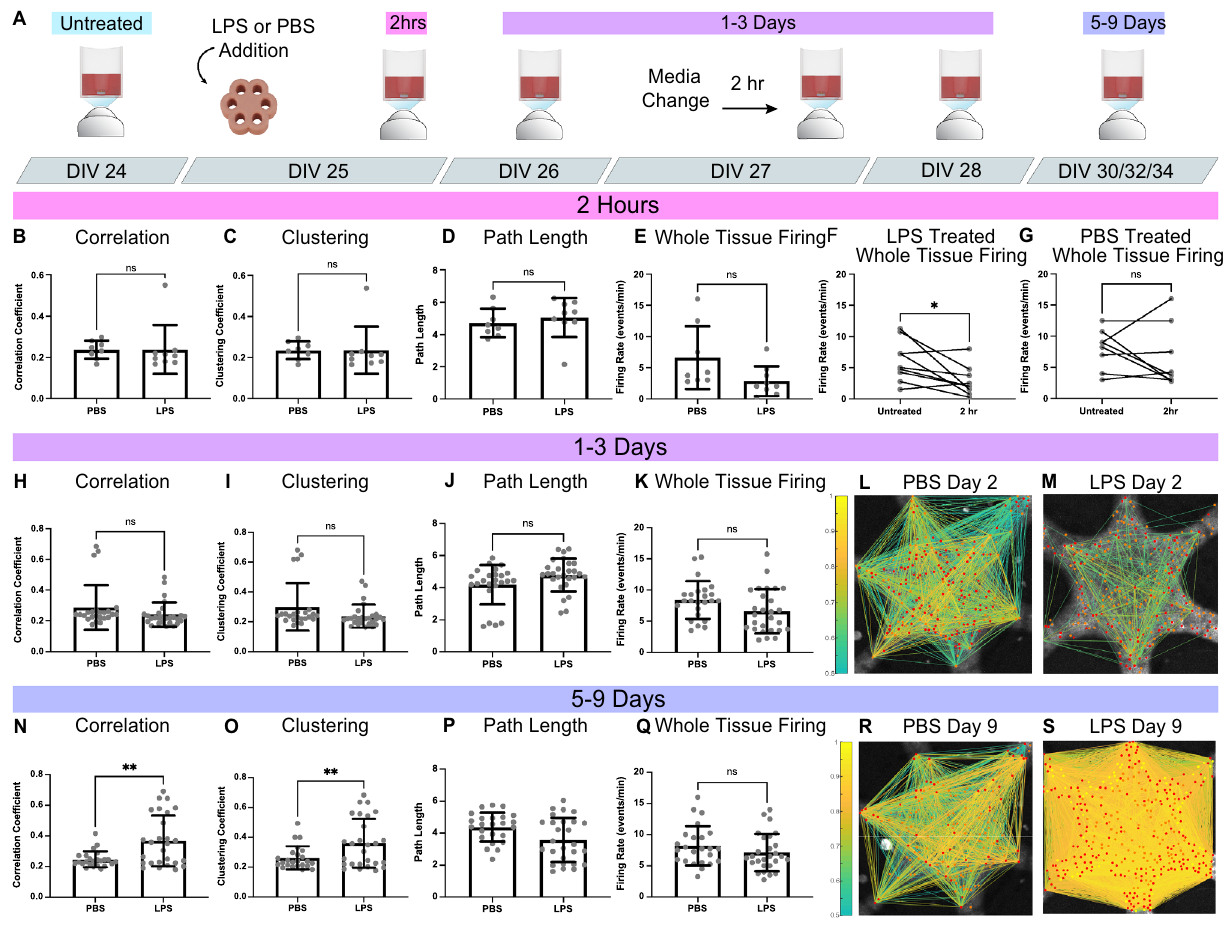
Figure 5. Lipopolysaccharide significantly increases functional connectivity 5–9 days after exposure. ( A ) Experimental timeline: LPS or PBS was added to the media at DIV 25, allowed to recover for 2 h, and then imaged (2 h). Subsequent image sessions were done at DIV 26, 27, 28 (1–3 Days) and DIV 30,32,34 (5–9 days). A media change was performed on DIV 27, with a 2-h recovery before imaging. At 2 h after exposure, there was no significant difference in average correlation coefficients ( p = 0.9805, B ), clustering coefficients ( p = 0.9924, C ), path length ( p = 0.5195, D ), or whole tissue firing rate ( p = 0.0636, E ) between PBS and LPS exposed tissues at 2 h. The 2 h treated samples were then compared to matched, untreated samples. The firing rate of PBS samples did not change ( p = 0.4479, F ), while the LPS samples significantly decreased ( p = 0.0249, G ). At 1–3 days after treatment, there was no statistical difference between PBS and LPS samples in average correlation coefficients ( p = 0.1539, H ), clustering coefficients ( p = 0.0769, I ), path length ( p = 0.0627, J ), or whole tissue firing rate ( p = 0.0580, K ). Example correlational connectomes from representative samples at 2 days after PBS ( L ) or LPS ( M ) treatment show similar correlation coefficient distributions above 0.5. At 5–9 days after treatment, LPS samples showed a significant increase in average correlation coefficients ( p = 0.0014, N ) and clustering coefficients ( p = 0.0096, O ), and a significant decrease in path length ( p = 0.0198, P ) compared to PBS samples. LPS exposure produced no statistical difference ( p = 0.2126) in firing rate ( Q ) at 5–9 days. An example correlational connectome from a representative microtissue 9 days after PBS exposure ( R ) shows similar correlation coefficient distributions above 0.5 to its 2-day counterpart, while the LPS connectome ( S ) reflects the increase in correlation compared to its 2-day counterpart as well as to the day-matched PBS sample. Significance comparing LPS to PBS samples was determined with unpaired, two tailed t-tests with p < 0.05 (* p < 0.05, ** p < 0.01). Significance comparing firing rate before and after treatment ( F , G ) was determined with a paired, two tailed t-test with p < 0.05 (* p <